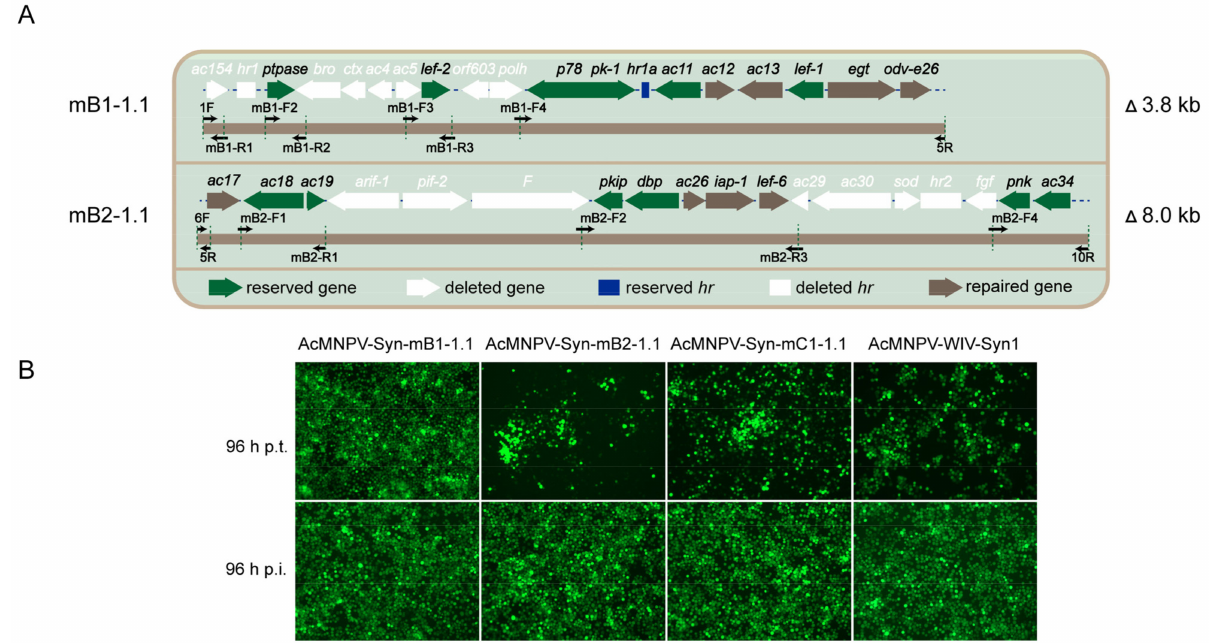
Figure 3. Redesign and characterization of AcMNPV-Syn-mB1-1.1, AcMNPV-Syn-mB2-1.1, and